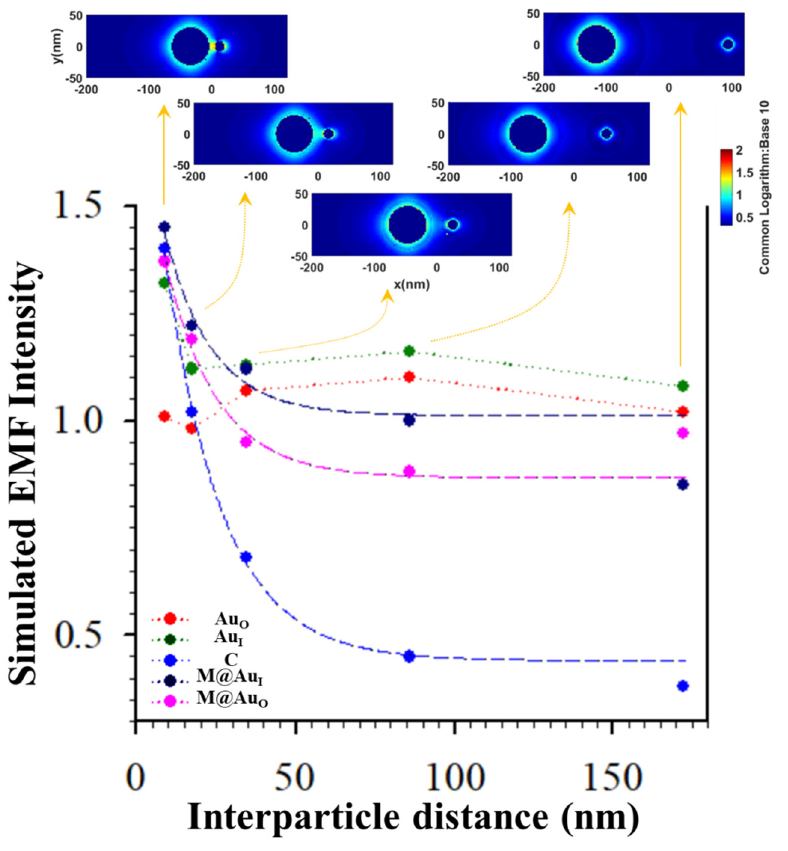
Figure 7. Plots of EMFs vs. interparticle distance for the dimer of “Ab1/Au 60 nm –antigen–Ab2/M 6 nm @Au 5 nm NP” at the different locations of Au O , Au I , C, M@Au I , and M@Au O . Inset: plasmonic field simulation results in terms of 2D plotting. Data were fitted by an exponential decay model yielding: y = 0.4412 + 1.5384 × e − 0.0556x (C, blue), y = 1.0123 + 0.7650 × e − 0.0679x (M@Au I , dark blue), and y = 0.8671 + 0.8674 × e − 0.0615x (M@Au O , pink) (see Figure